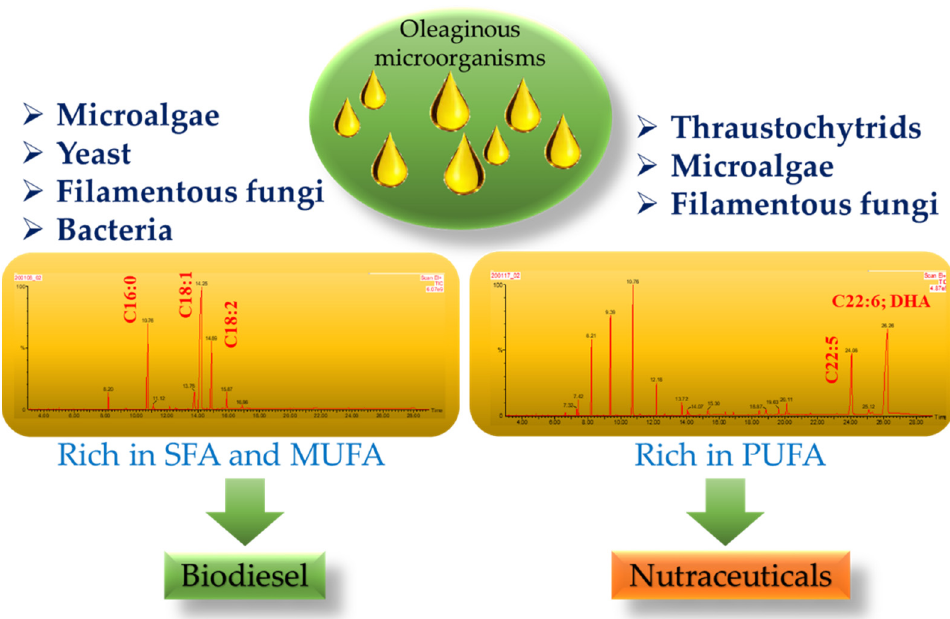
Figure 1. On the basis of the fatty acid profiles, oleaginous microorganisms can be used for biodiesel production or nutraceuticals. Some oleaginous microorganisms such as microalgae, yeast, fungi, and bacteria are rich in saturated and monounsaturated fatty acids in their oils, while some of them are a good source of polyunsaturated fatty acids such as thraustochytrids and microalgae. Several species of microalgae, bacteria, fungi, and yeast can synthesize more than 20% w/w of lipids on the basis of cell dry weight in their cellular compartment and are known as oleaginous microorganisms [13]. Certain species can synthesize lipids up to 70% w/w on a cell dry weight basis depending on the cultivation conditions, such as under high C/N ratio [16]. The majority of lipids synthesized by oleaginous microorganisms are of 4 to 28 unbranched carbon chain length [17]. It can be saturated or unsaturated fatty acids depending on the nature of the hydrocarbonated chain, while it can be monounsaturated or polyunsaturated fatty acids (MUFA and PUFA) depending on the number of double bonds [18]. On the basis of the fatty acid profiles of oleaginous microorganisms, they can be utilized either for biodiesel production or for nutraceuticals (Figure 1). A very interesting investigation was carried out by Tchakouteu et al. (2014) to show the interaction between intracellular total sugars (ITS) and lipid synthesis in oleaginous yeast Cryptococcus curvatus [19] . When this strain was cultivated in lactose and sucrose under nitrogen-limited conditions, it accumulates high quantity